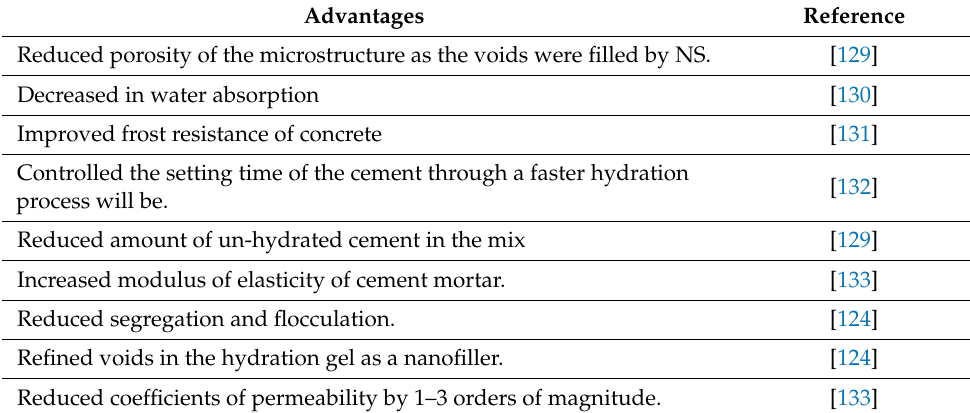
Table 3. Advantages of using nano-alumina (NA) in